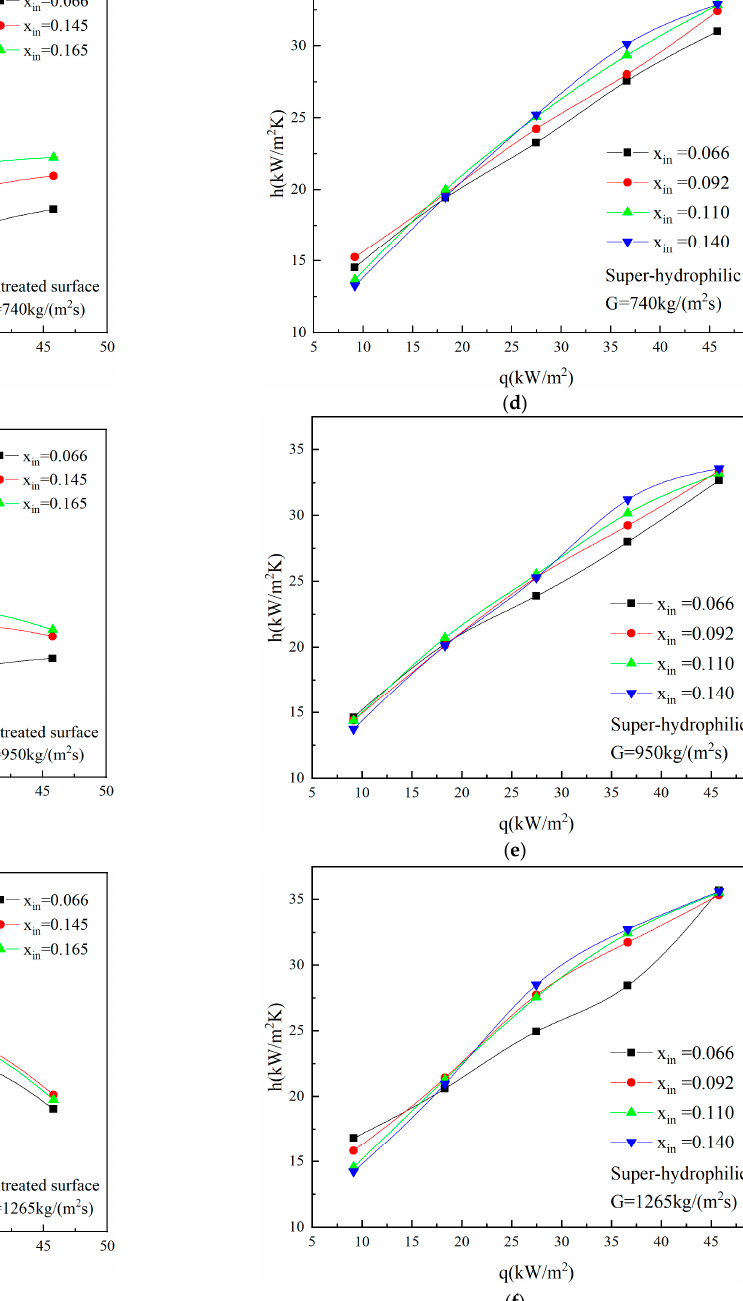
Figure 4. The variation trend of average heat transfer coefficients with the increase of heat fluxes under different inlet vapor qualities for ( a–c ), untreated surface microchannel and ( d–f ), super-hydrophilic microchannel.